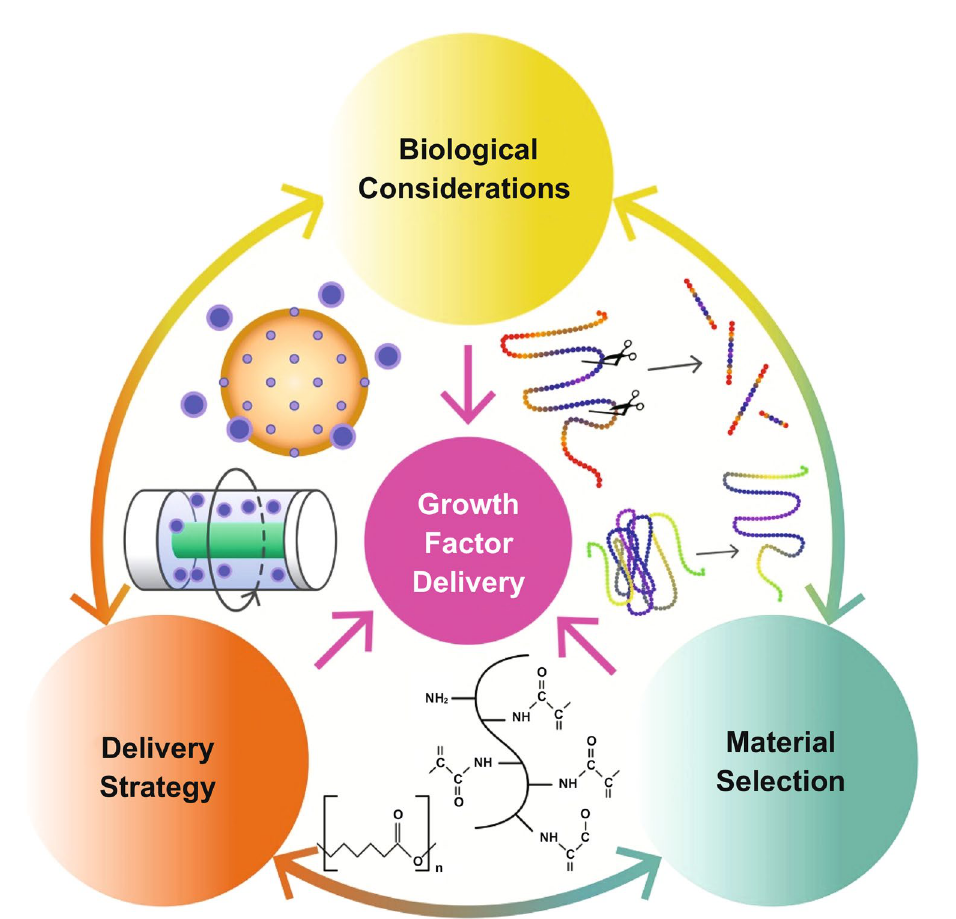
Fig. 3 A schematic illustration regarding the delivery of GFs and effect of each key factors on this delivery system